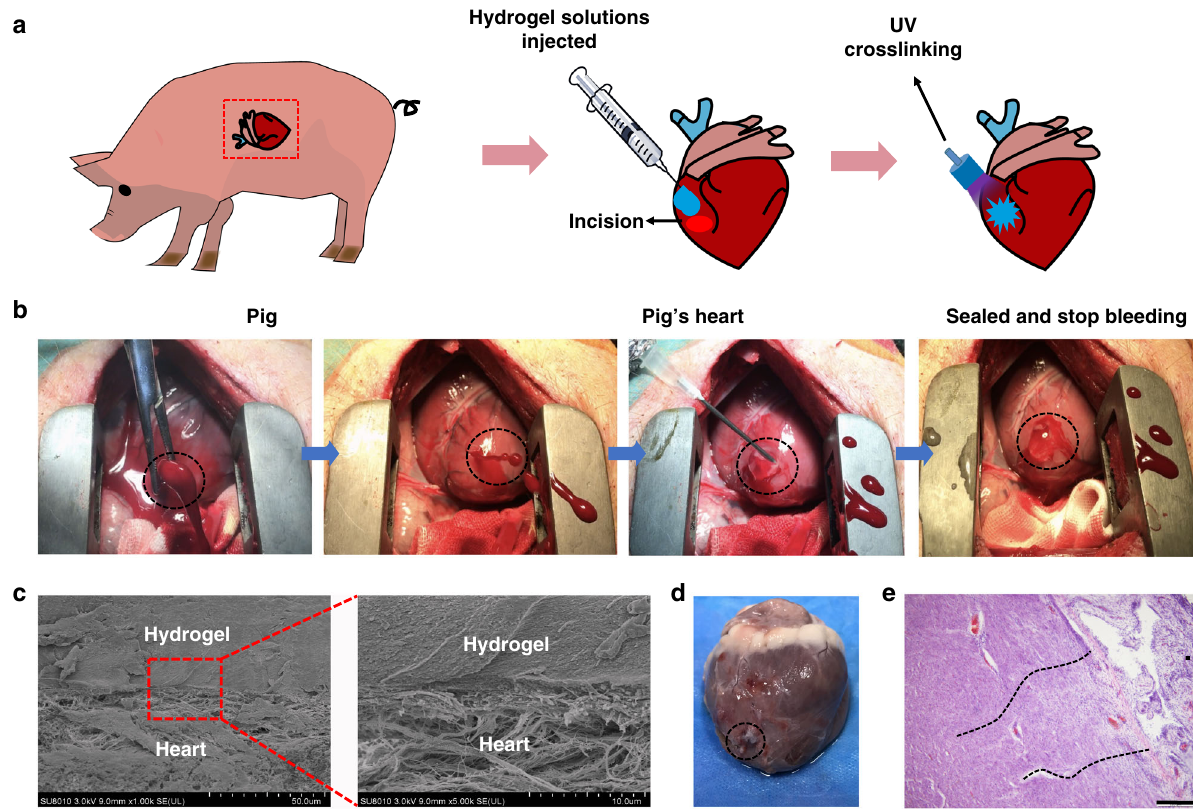
Fig. 4 Hemostatic properties of the matrix gel in a pig cardiac puncture injury model. a Schematic diagram of the surgical procedure. b Gross view of the rapid hemostasis and sealing following cardiac puncture injury: the ventriculus sinister of the pig hearts was pierced by a 6 mm (inner diameter) needle, causing immediate high-pressure blood expulsion, subsequently continuing blood expulsion following needle removal. Then, the matrix gel was injected to cover the blood hole and rapidly irradiated with UV. After UV-induced rapid polymerization, the bleeding stopped completely within 10 s (four experimental operations were carried out). c Scanning electron micrographs of the interface between the pig heart puncture wound and the hydrogel. These sections derive from immediate postoperative autopsy on the heart of one pig, which was immediately killed after successful hemostatic treatment. Scale bar: 50 μ m (left plates); 10 μ m (right plates, enlarged). d Images of a heart autopsy following killing after two 2 weeks of postoperative recovery, the hydrogel still adhering to the wound, without any gap between gel and tissues, indicating continuous strong bonding at the healing interfaces. e Tissue staining images of the interface between pig heart cardiac tissue and the matrix gel, after 2 weeks of postoperative recovery. Scale bar: 200 μ m ( n = 4) Source data are available in the Source Data fi